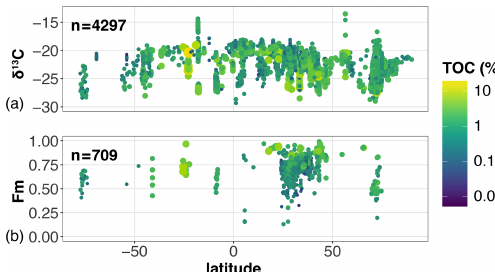
Figure 5. Latitude (a) versus δ 13 C (‰) and (b) Fm, with colour indicated by TOC content (%). The δ 13 C tends to be less depleted at the low latitudes. The Fm shows a sampling bias at the mid-range latitudes and also appears to be less depleted at the lower